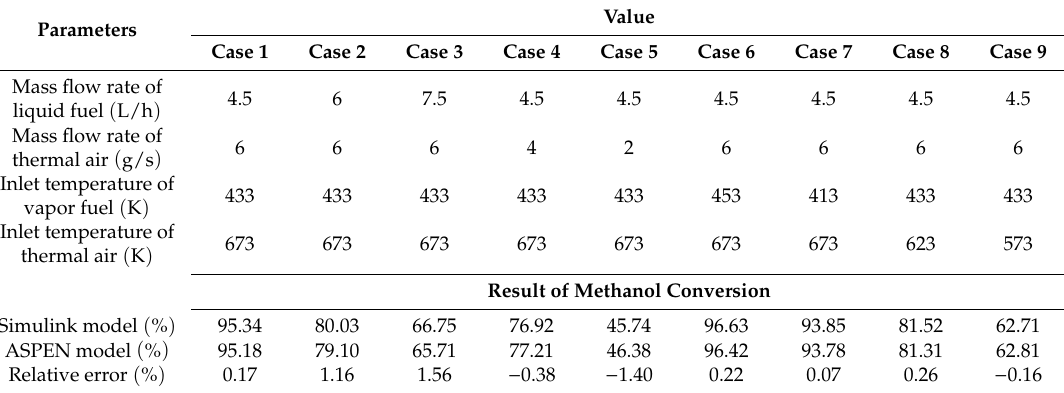
Table 5. Comparison of the methanol conversions calculated by Simulink model and Aspen model.